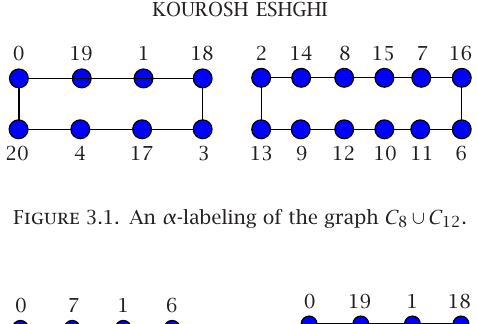
Figure 3.1 . An α -labeling of the graph C